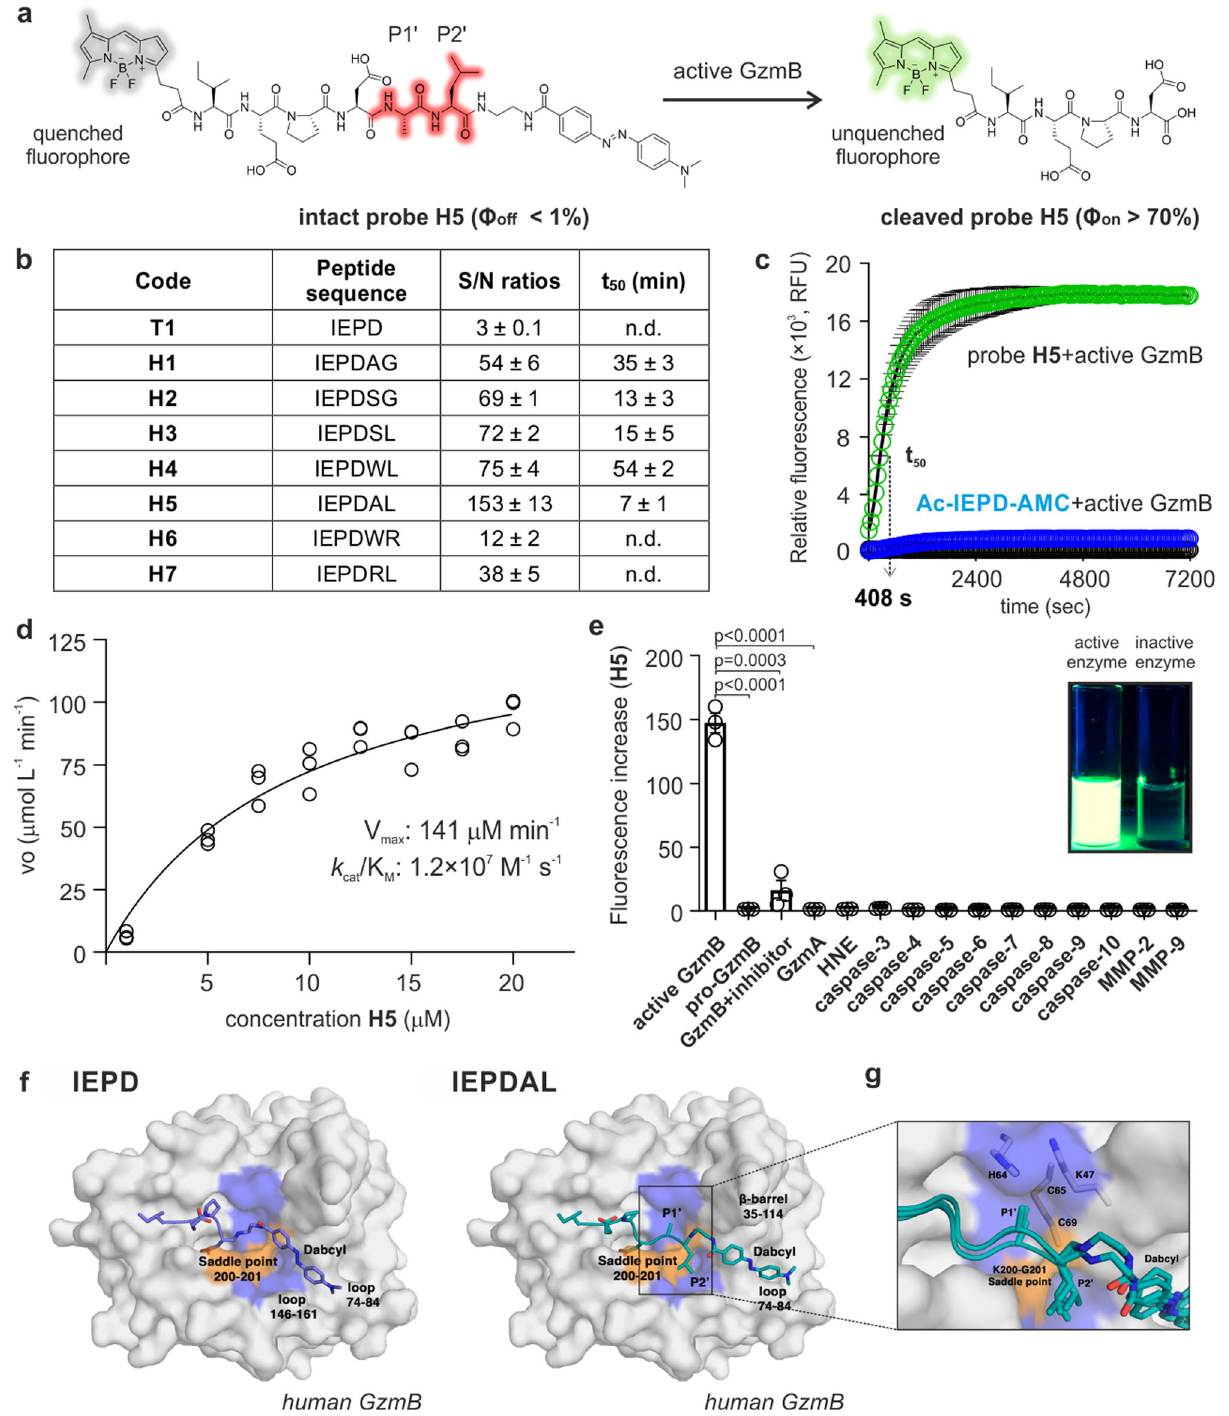
Fig. 1 The hexapeptide H5 achieves high reactivity and selectivity for GzmB by accessing a unique binding pocket. a Fluorogenic hexapeptide H5 and fl uorescence quantum yields of intact and cleaved probe. b Tetra- and hexapeptide sequences, fl uorescence increases and t 50 values upon incubation (25 μ M) with hGzmB (20 nM). Data as means± SEM ( n = 3). c Time-course fl uorescence of H5 (25 μ M, green, 510 nm) and Ac-IEPD-AMC (25 μ M, blue, 450 nm) after incubation with hGzmB (20 nM) at 37 °C. Probe H5 alone (25 μ M, black, 510 nm). Data as means± SEM ( n = 5). d Cleavage rate of probe H5 by hGzmB (20 nM) as a function of substrate concentration. Data as individual replicates and kinetic values determined using the Michaelis-Menten equation ( n = 3). e Fluorescence changes of probe H5 (25 µ M) after incubation with proteases (20 nM) at 37 °C for 60 min. Data as means± SEM ( n = 3). For active GzmB vs pro-GzmB, p < 0.0001. For active GzmB vs GzmB + inhibitor, p = 0.0003. For active GzmB vs GzmA, p < 0.0001. f Representative binding mode of IEPD-Dabcyl in T1 (left) and IEPDAL-Dabcyl in H5 (right) from the MD simulations. g Detailed interactions at P1 ’ and P2 ’ sites for the probe H5 with overlaid structures from 3 independent runs. P -values from two-tailed t -tests. Source data ( b – e ) provided as a Source Data fi le.